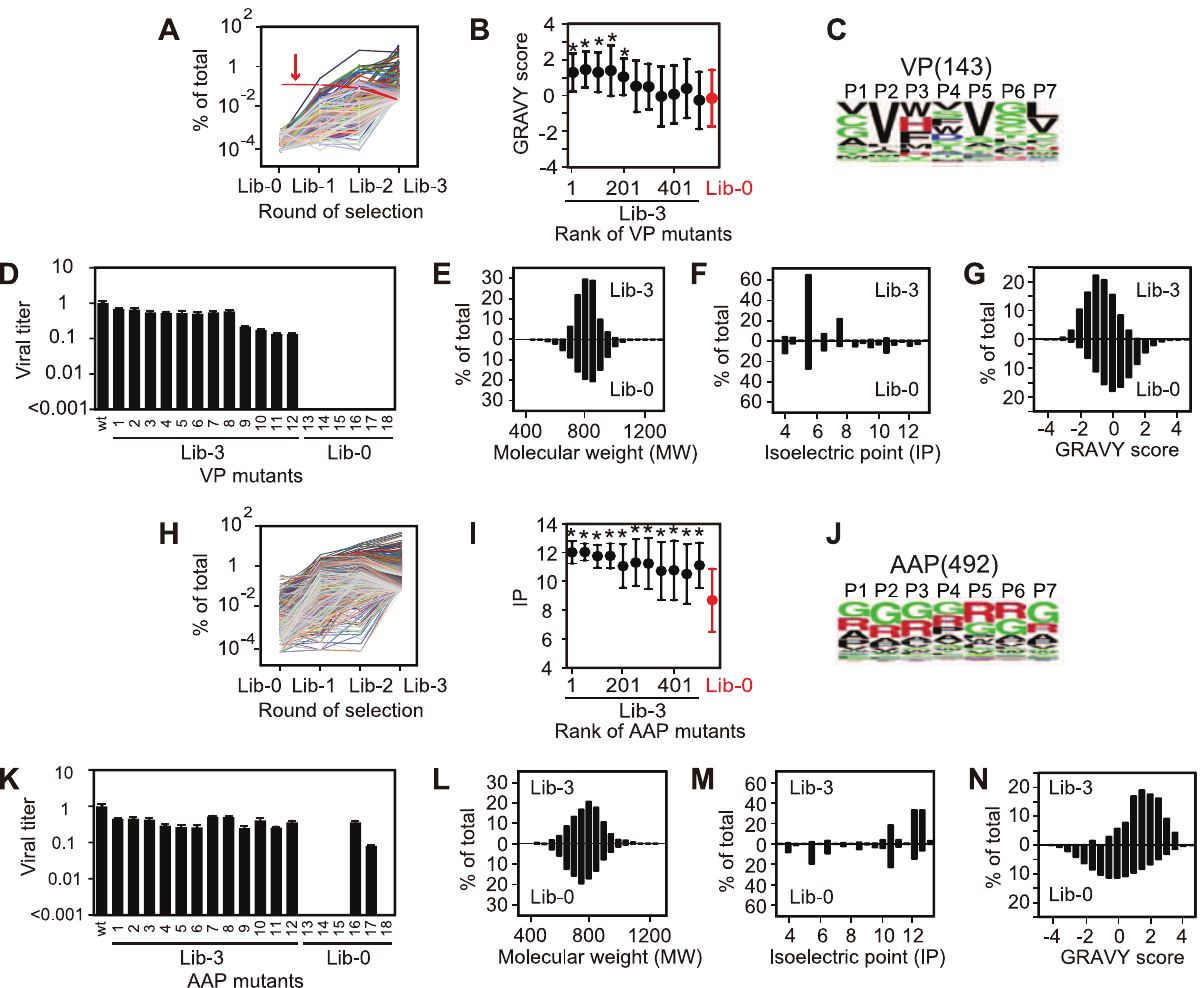
Figure 3. The results of the experimental evolution of VP and AAP heptapeptides and their biochemical characterization. ( A and H ) Evolutionary history of the viable VP (Panel A) and AAP (Panel H) heptapeptide mutants. Percentage of sequence reads of each mutant among all the sequence reads is plotted as a function of the number of selection cycles. The red line with an arrow in Panel A represents GGGGGGG. ( B and I ) Chemical properties of top-ranked VP (Panel B) and AAP (Panel I) heptapeptides with no stops identified in Lib-3. Top-ranked 550 heptapeptides are divided into 11 bins (50 peptides per bin) according to their rank. Red lines indicate chemical properties representing all the 930372 VP heptapeptides and 554743 AAP heptapeptides in Lib-0. Asterisks indicate statistical significance with P , 0.05 and power . 0.8 (Mann Whitney U-test) when compared to the values of Lib-0. The power analysis was performed by comparing 50 heptapeptides in each bin with 50 randomly selected heptapeptides from Lib-0 100 times. Vertical bars represent standard deviations. ( C and J ) Amino acid frequency plots of the 143 viable VP heptapeptide mutants (Panel C) and the 492 viable AAP heptapeptide mutants (Panel J) identified by the experimental evolution of random nucleotide sequences. ( D and K ) Experimental validation of the capsid-forming ability of the viable VP (Panel D) and AAP (Panel K) heptapeptides identified by the experimental directed evolution procedure. In Panel D, relative titers of wild type and mutant AAV2 VP3 only viral particles recovered from one 6 cm dish are shown. The VP heptapeptide sequences selected from the viable 143 VP heptapeptide mutants found in Lib-3 ( i.e. , 1 through 12) and those selected from the random mutants found in Lib-0 ( i.e. , 13 through 18) are as follows: 1, SAYWVTQ; 2, TVWASSV; 3, CLHDVMS; 4, SVHDACV; 5, GVFWVGV; 6, VVHDVSD; 7, CVRDVTL; 8, CVWSVGL; 9, 10, QVWDERY; 11, AVMTVCS; 12, CVFFSSF; 13, PHNFVAL; 14, LDDFLEF; 15, EGPCGGL; 16, RGAEWNK; 17, GGRWGRG; 18, GVAWGVG. In Panel K, relative titers of wild type AAV2 VP3 only viral particles produced with wild type or each mutant AAP in one 6 cm dish are shown. The AAP heptapeptide sequences in the AAP mutants selected from Lib-3 ( i.e. , 1 through 12) and Lib-0 ( i.e. , 13 through 18) are as follows: 1, GGGRRRR; 2, RGRRRRW; 3, VRRRRGG; 4, WRRPRRV; 5, PRLSRRR; 6, APGRGAR; 7, RGGRRRA; 8, GRVGPRG; 9, RRVGRLG; 10, PGRGRRG; 11, VGGGGRR; 12, GERKGRG; 13, RSSPALR; 14, PGGGSIS; 15, GAQVGVV; 16, GGARRGG; 17, RGHDGAS; 18, ACWRLF_ (a stop codon follows after F). All the experiments were performed in triplicate. ( E, F, G, L, M, and N ) Histograms showing chemical properties (MW, IP and GRAVY score) of the viable VP (Panels E, F and G) and AAP mutants (Panels L, M and N). In each graph, upper bars represent histograms of the viable 143 VP or 492 AAP heptapeptide mutants found in Lib-3 and lower bars represent histograms of 930372 VP and 554743 AAP heptapeptides found in Lib-0. doi:10.1371/journal.pone.0066211.g003 ranked 550 clones was significantly different from that in the AAV particles efficiently, while only 2 of 5 mutants from the non- library Lib-0 ( P = 0.000011 to 0.049860, Mann-Whitney U-test, selected library Lib-0 excluding the one with a stop codon retained Table S3). Furthermore, 12 AAV2-CMV-cmAAP mutants select- the AAP function ( Figure 3K ). These observations provide ed from the top-ranked 492 clones were all viable and generated evidence that the top-ranked majority of the 492 mutant clones, if